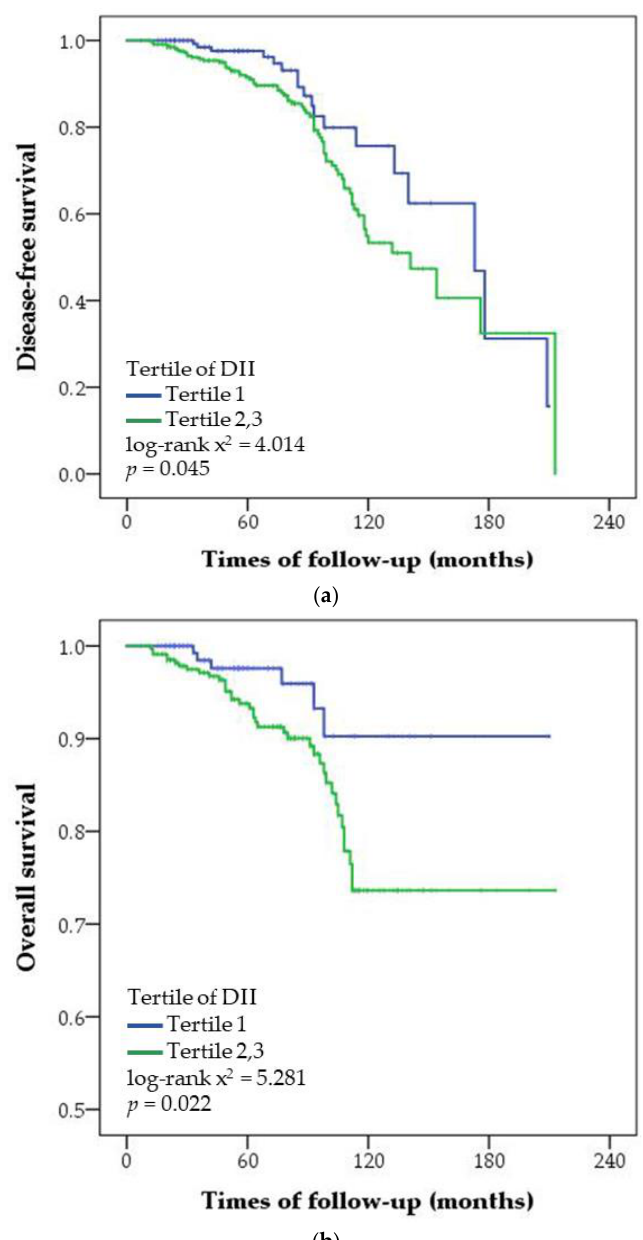
Figure 1. Cumulative disease-free survival ( a ) and overall survival ( b ) according to the tertiles of the dietary inflammatory index (DII) score in patients with breast cancer. Statistical significance was determined using log-rank test and Kaplan–Meier method.